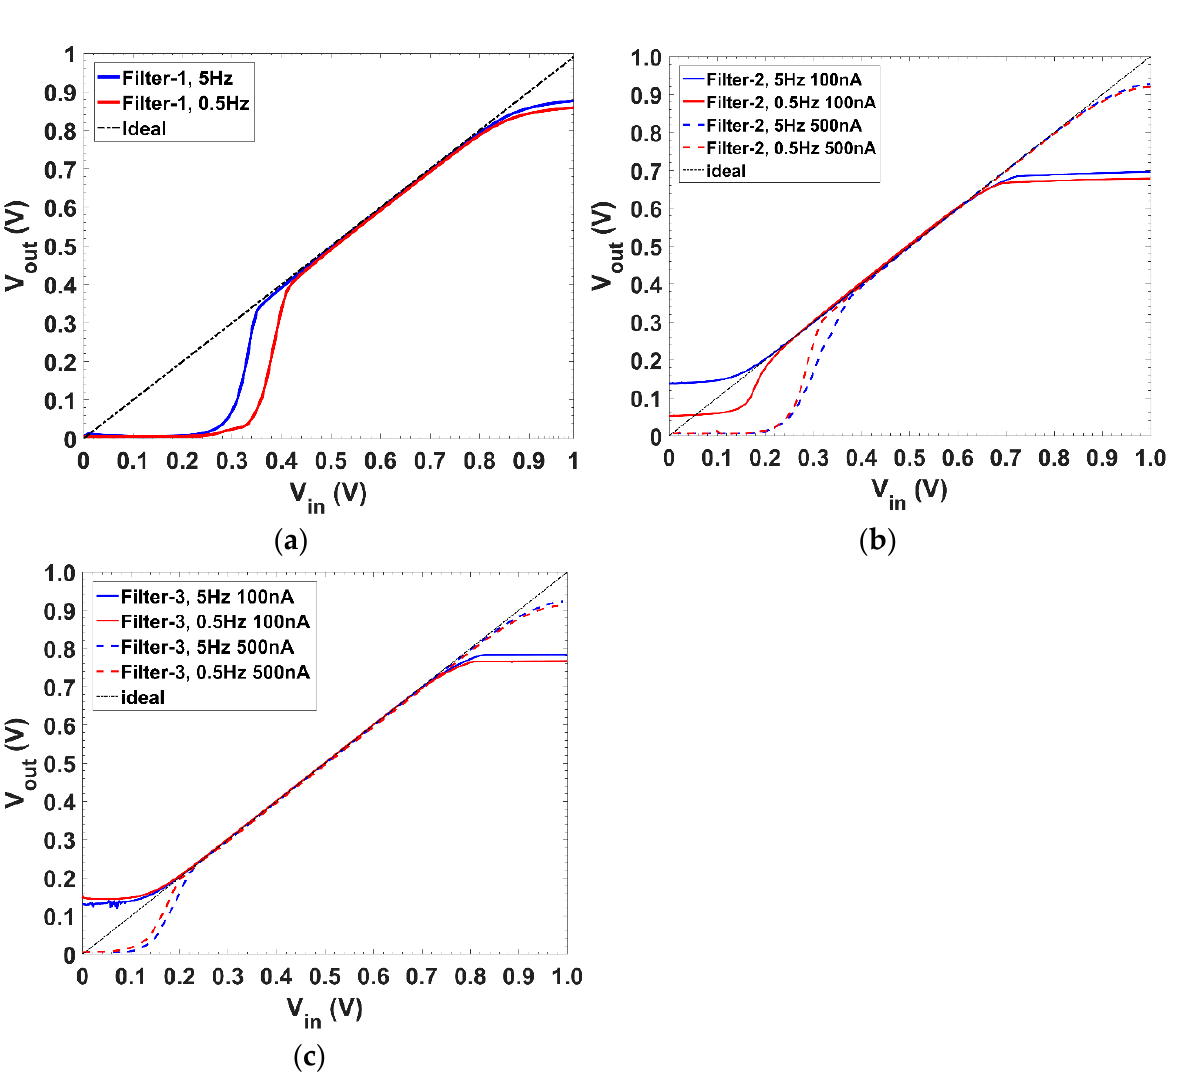
Figure 12. ICMR at fc 5&0.5 Hz for: ( a ) Filter-1; ( b ) Filter-2; and ( c ) Filter-3.